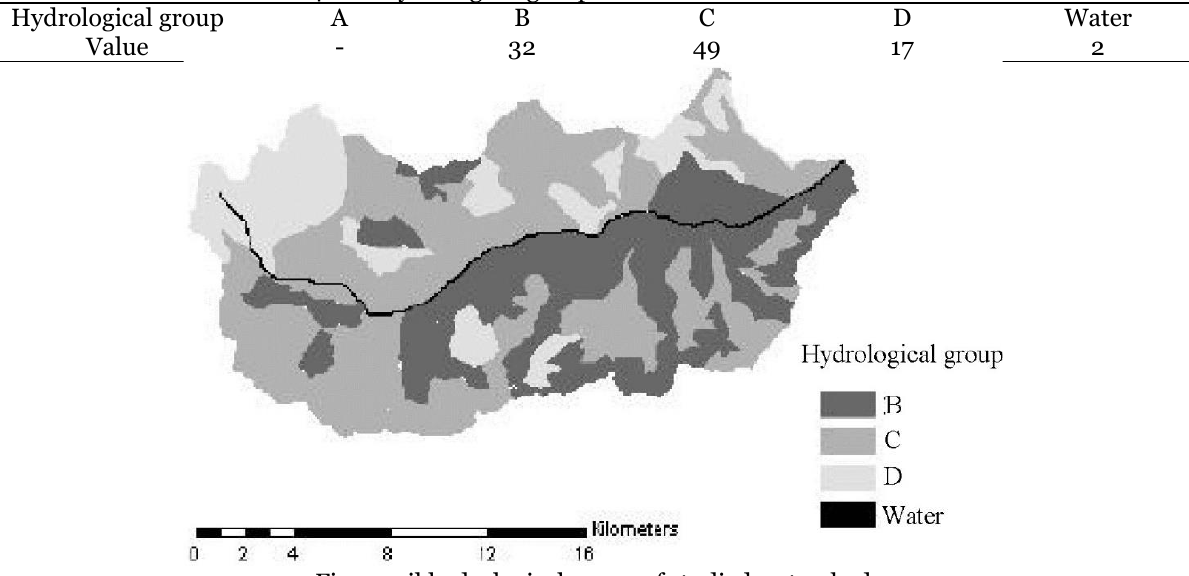
Fig.4. soil hydrological group of studied